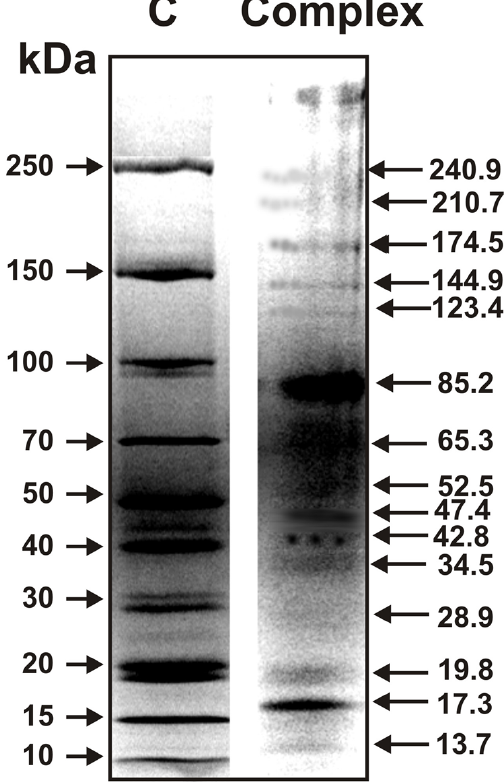
Figure 3. SDS-PAGE analysis of the proteins of sea cucumber complex (25 µ g) using 3.0–17.0% gradient gel. The arrows of Lane C indicate the positions of markers of molecular masses. See Materials and Methods for other